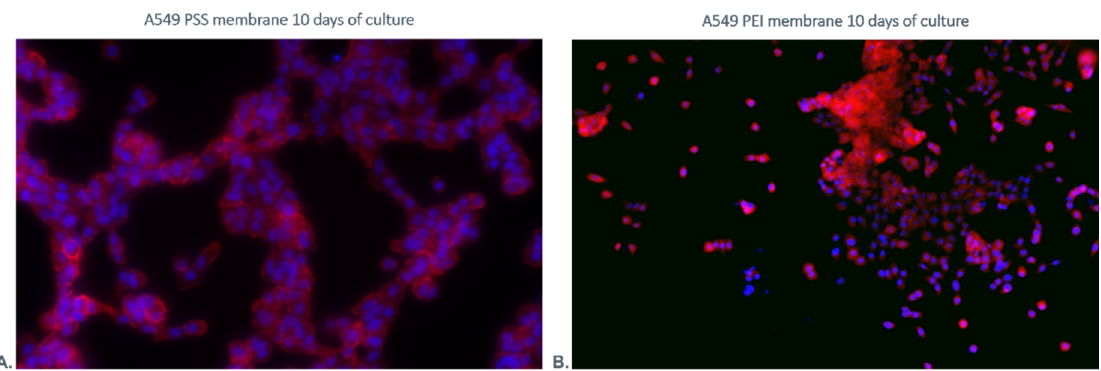
Figure 12. Visualization of cultured A549 cells grown on ( A ). PSS and ( B ). PEI membranes after 10 days of culture. The nuclei of cells are stained in blue. The red fluorescence shows